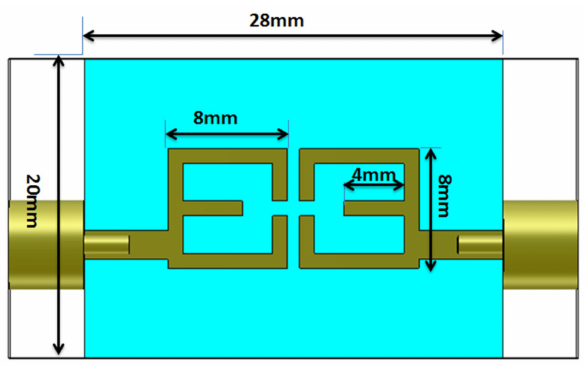
Figure 5. Second-order OLR with stub band-pass filter with 180 ◦